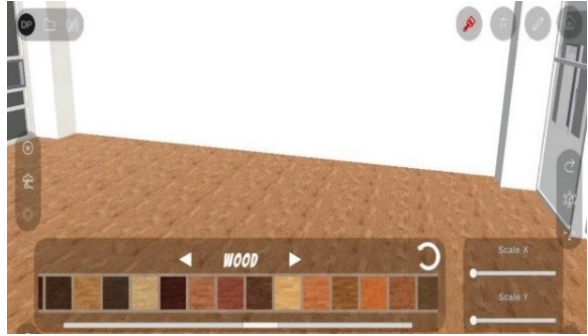
Figure 14. Implementation of material change function.